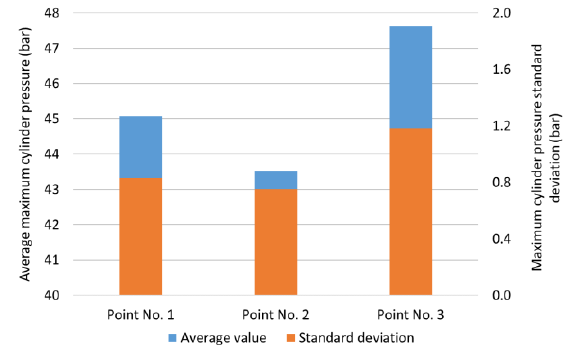
Fig. 11. Average value and standard deviation of maximum cylinder pressure